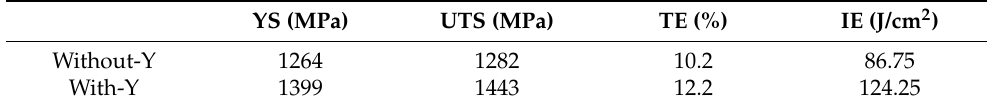
Figure 7. ( a ) Stress–strain curves of the formed parts with Y and without Y; ( b ) oscillographic impact curve of the shaped parts with different yttrium content. Table 3. Mechanical properties of the formed parts with Y and without Y.